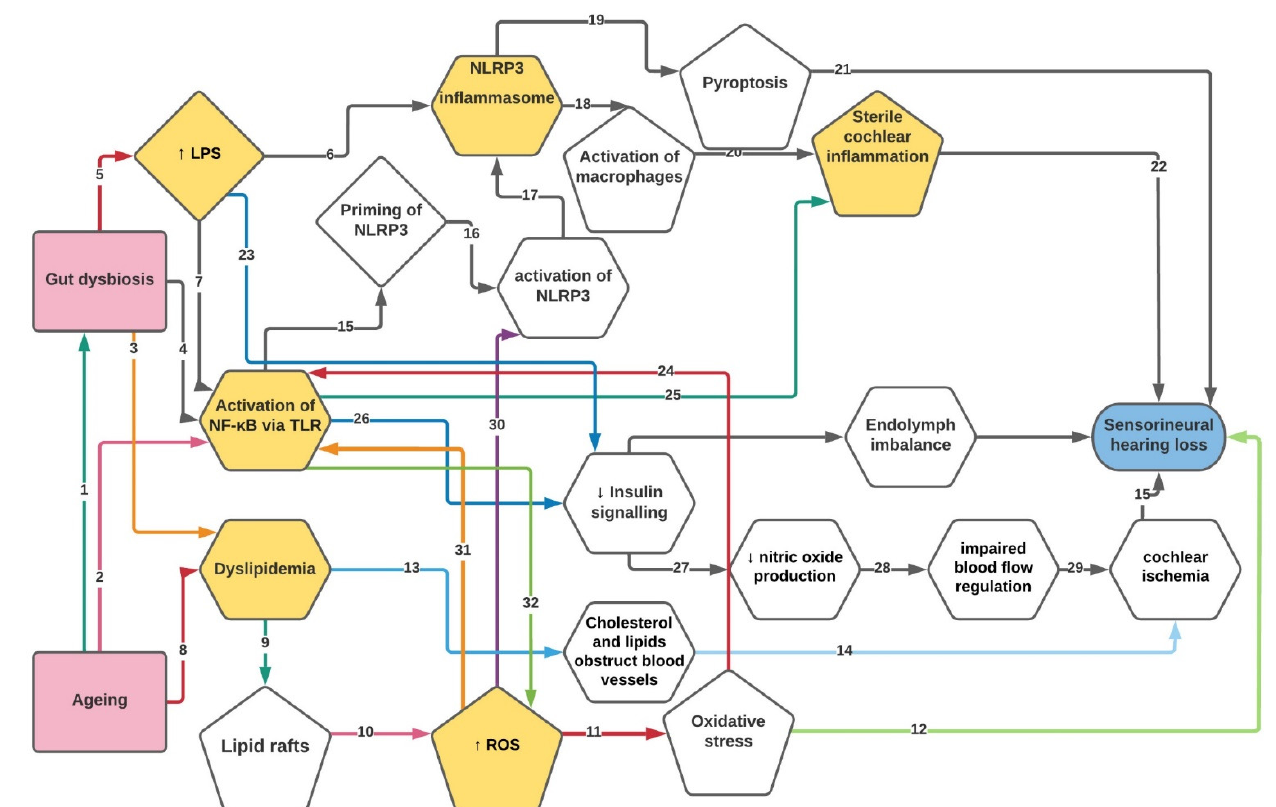
Figure 1. The proposed relationship between ageing, gut dysbiosis, and hearing loss. Numbers in arrows indicate a pathway described below. Abbreviations: LPS—lipopolysaccharides; ROS—reactive oxygen species; NF- κ B—nuclear factor kappa-light-chain-enhancer of activated B cells; TLR—toll-like receptor; NLRP3—Nod-Like Receptor Pyrin domain-containing protein 3. Ageing is associated with developing gut dysbiosis, and it was proposed that dysbiosis is an underlying cause of age-related morbidities ( 1 ) [165,178]. As humans age, inflammaging results from the activation of NF- κ B signalling pathways ( 2 ) [179]. In addition, the leaky intestinal barrier causes the release of bacterial metabolites into the bloodstream, systemic inflammation, activation of NF- κ B ( 4 ), and ROS overproduction ( 32 ) [180–182]. Activation of NF- κ B may result in reduced insulin signalling ( 26 ) [183,184], which can lead to sterile cochlear inflammation ( 25 ) [185,186], and priming of NLRP3 ( 15 ) [187–189]. Ageing ( 8 ) and gut dysbiosis ( 3 ) are both associated with dyslipidemia [22,170,190–192]. Dyslipidemia can lead to the narrowing of cochlear blood vessels ( 13 ) [193–195] and lipid raft formation ( 9 ) [196–198]. Lipid rafts lead to the accumulation of ROS ( 10 ) [197] and oxidative stress (OS) ( 11 ) [197,199]. OS can activate the NF- κ B pathway ( 24 ) [200,201] and cause cochlear damage and hearing loss ( 12 ) [202–208]. The cholesterol and lipids obstructing cochlear vessels lead to cochlear ischemia ( 14 ), which also contributes to cochlear damage ( 15 ) [209–214]. Insulin resistance can lead to an electrochemical imbalance in endolymph by decreasing the expression of the sodium-potassium pump NKCC1 , reducing the endocochlear potential [215–217]. Insulin resistance also decreases nitric oxide production ( 27 ) [218,219] resulting in impaired blood flow regulation ( 28 ) [188,220], cochlear ischemia ( 29 ) and eventually hearing loss ( 15 ) [221,222]. Gut dysbiosis can lead to increased levels of circulating lipopolysaccharide (LPS) ( 5 ) [223–228]. LPS is a bacterial metabolite that can activate NF- κ B via toll-like receptors (TLRs) ( 7 ) [229,230]. LPS also affects insulin signalling ( 23 ) [231,232] and contributes to NLRP3 inflammasome activation [233]. After priming via the NF- κ B signalling pathway ( 15 ), NLRP3 is activated via ROS ( 30 ), resulting in NLRP3 inflammasomes ( 17 ). NLRP3 inflammasomes can cause pyroptosis ( 19 ) [234], which also produces cochlear damage [32] ( 21 ). NLRP3 can also initiate the activation of cochlear macrophages ( 18 ) [32], which can increase the BLB permeability and induce sterile cochlear inflammation ( 20 ) [22,235,236], leading to hearing loss ( 22 )